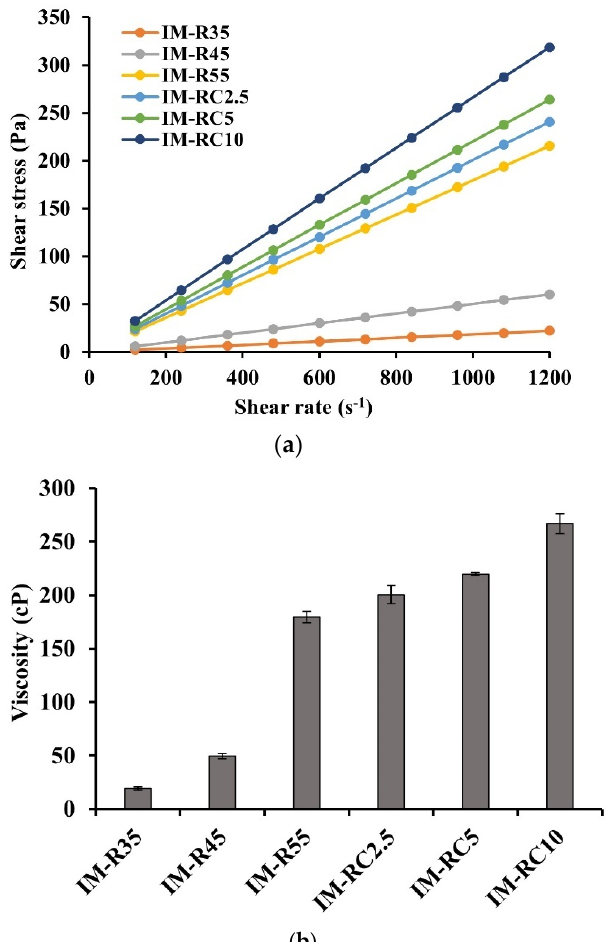
Figure 1. Relationship between the shear stress and shear rates ( a ) and viscosity ( b ) of IM-loaded rosin/CO-based ISG formulations at 25 °C. The data are represented in triplicates. Figure 1b shows the effect of rosin and CO concentrations of ISG formulations on viscosity. Increasing the rosin concentration enhanced the viscosity of the ISG formulations. The viscosities of the ISG formulations for IMR35, IMR45 and IMR55 were 19, 49 and 179 cP, respectively. The viscosity of the ISG systems notably increased as the CO concentration increased from 2.5 to 10% (IM-RC2.5, IM-RC5 and IM-RC10). It was found that the viscosity values of the CO-added ISG formulations significantly increased ( p < 0.05) compared to IMR55. These prepared ISG systems showed a viscosity value of less than that of 5% doxycycline hyclate-loaded rosin/lime-peel-oil-based ISG system, whose values were in the range of 624.51–684.15 cP [45]. The hydrophobic nature of CO promoted a more viscous character, which was consistent with previous research [25]. Additionally, the solvent exchange-induced ISG system presented a lower viscosity than the hydrogel-based injectable ISG system [47]. In this study, the viscosity of all prepared ISG systems was appropriate for injection because of a viscosity threshold of less than 300 mPas [48]. Typically, the lower viscosity of polymeric solution is attained when a solvent with a high potential to dissolve that polymer is used. In addition, the viscosity value was lower than other injectable thermo-responsive in situ forming gel systems, such as carbopol–poloxamer gels whose viscosity values are in the range of 19,000–36,000 mPas at 4 °C [49,50]. Therefore, the solution state with a less viscous character of IM-loaded rosin/CO-based ISGs exhibits the potential minimized painful application via injection through the needle as confirmed with subsequent injectability test. 2.2. Injectability and Mechanical Properties The prepared formulations’ injectability through 21- and 24-guage needles is displayed in Table 1. The data were obtained from the area under the curve of the force/distance profile [51]. The formulations without the addition of CO were more easily injected through the 21- and 24-guage needles. Furthermore, as the rosin and CO concentrations were increased, the work required to expel the formulations through the needles also increased due to their rather high viscosity values [52]. These injectability data were consistent with our previously reported oil-incorporated ISG systems. The addition of peppermint or lime peel oil increased the force of injection of the ISG system significantly [24,25]. The oil inclusion also enhanced the injection force of the in situ forming micro-particle system more than the in situ forming gelling system [53]. Although the ISG system with CO addition required a higher force of injection than other